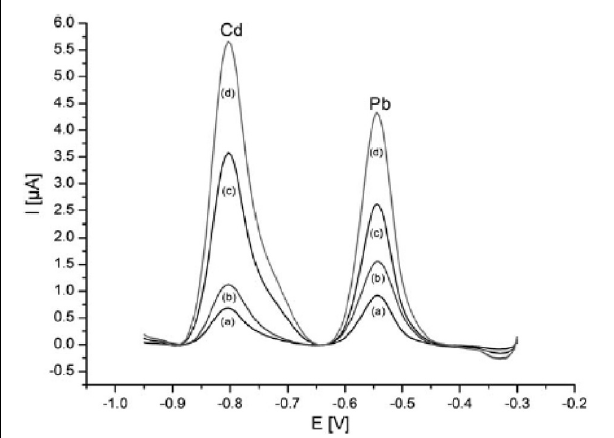
FIGURE 1 | DPASV voltammograms for increasing level of Cd and Pb in the 20–130ppb range on porous Bi film (gold substrate) electrode. Reprinted with permission from Urbanova et al. (2010). Copyright 2010